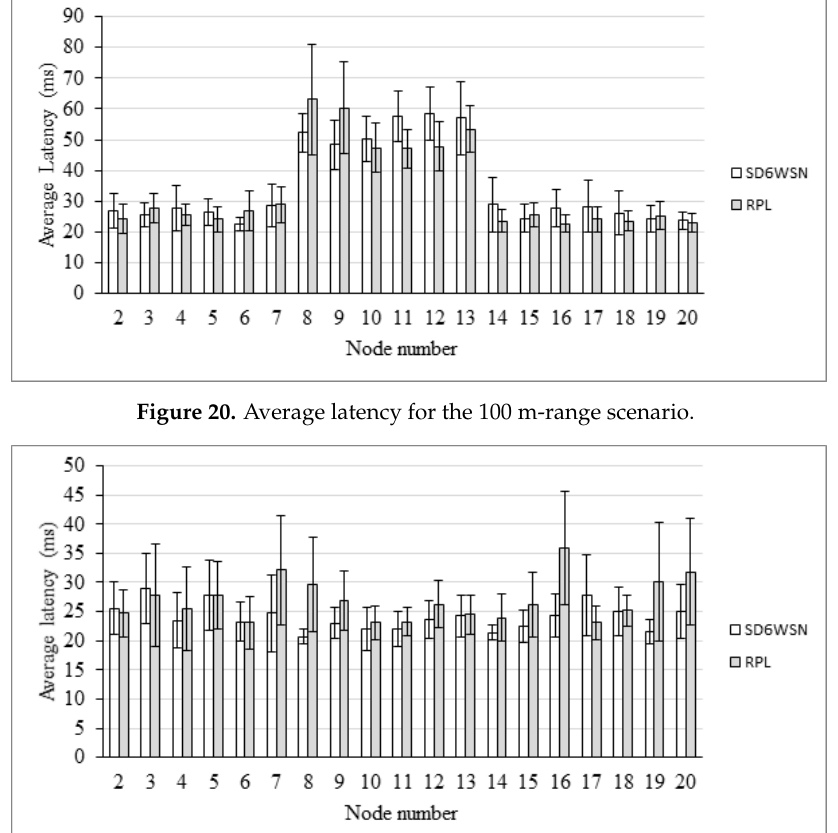
Figure 21. Average latency for the 150 m-range scenario.